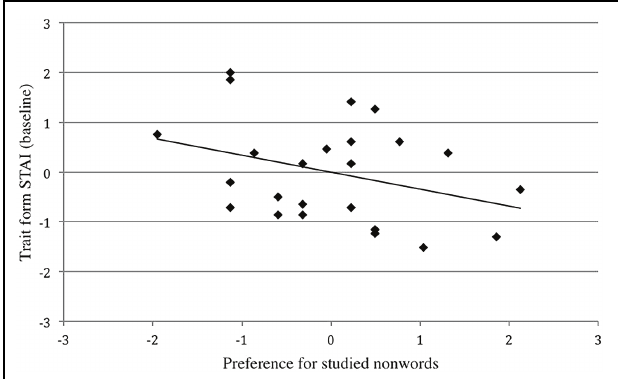
FIGURE 1 | Scatterplot of standardized-scores for the trait form of the State–Trait Anxiety Inventory (STAI) with preference for studied nonwords, Study 1. Greater trait anxiety correlated with reduced preference for studied nonwords, r = − 0.34, p =